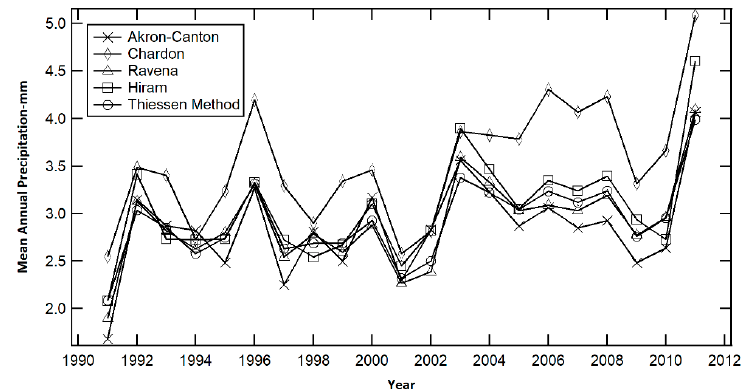
Figure 2. Mean annual precipitation measured across the watershed. The Thiessen method is used to estimate the average precipitation from the four gages.